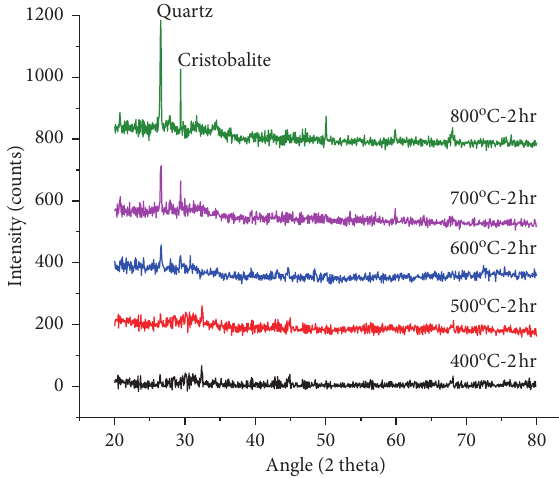
Figure 5: Weight loss of corn stalk ash at different temperatures. Figure